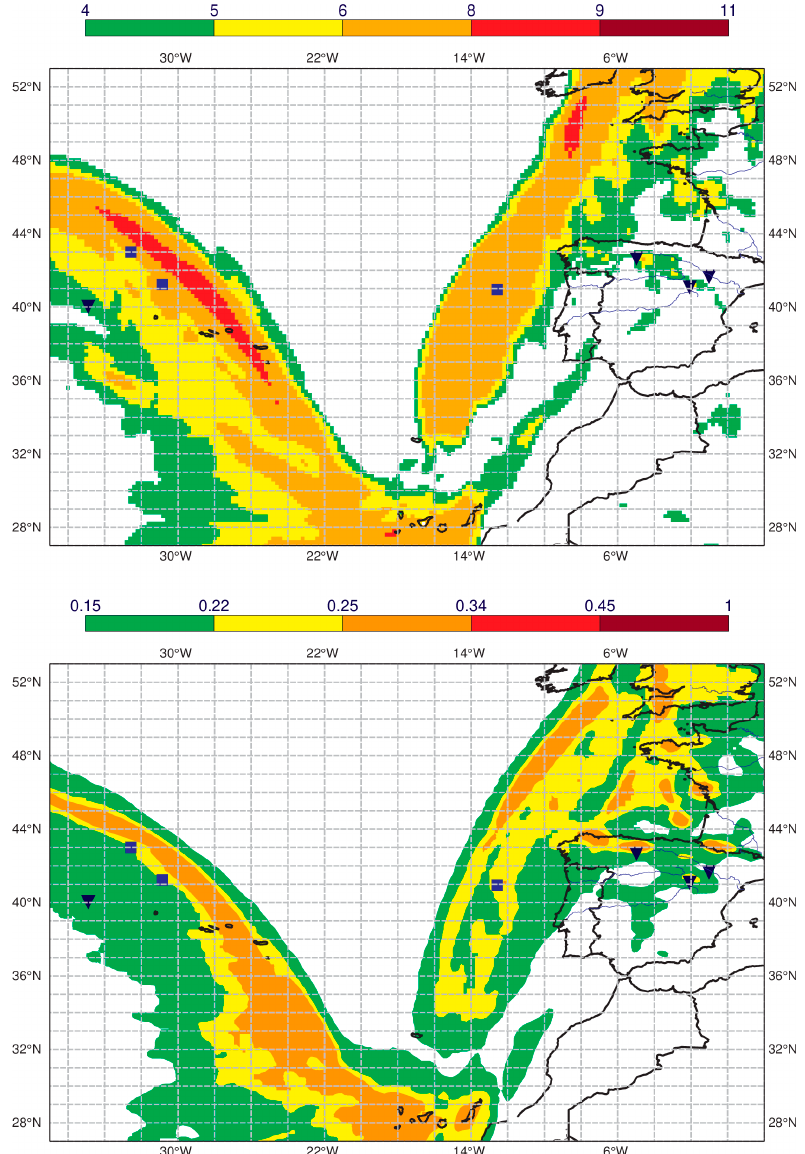
Figure 12. TURB LAYER ( top panel ) and EDR product from London WAFC ( bottom panel ), for the FL300/390 layer. Both forecasts are valid at 15UTC on 20 February 2021. The square and the inverted triangle represent, respectively, moderate (MOD) and severe (SEV) turbulence reports above FL350.